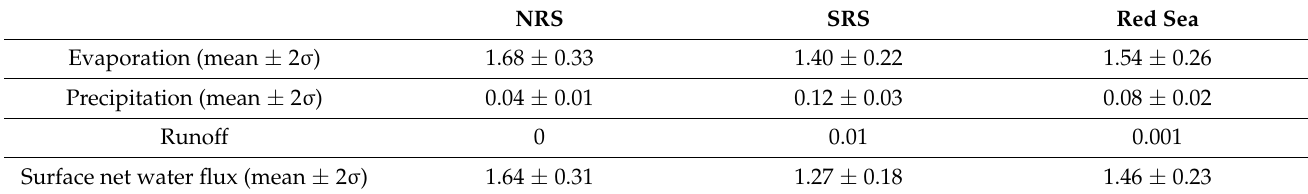
Figure 6. ( a ) Spatial distribution of the evaporation (m/yr) over the Red Sea from 1981 to 2020. ( b ) Spatial distribution of the precipitation (m/yr) over the Red Sea from 1981 to 2020. ( c ) Spatial distribution of the surface net water flux (m/yr) over the Red Sea from 1981 to 2020. Table 2. Mean net water flux components (evaporation, precipitation and runoff) in m/yr with standard deviation (± 2 σ, m/yr) for the NRS, SRS and whole Red Sea from 1981 to 2020.